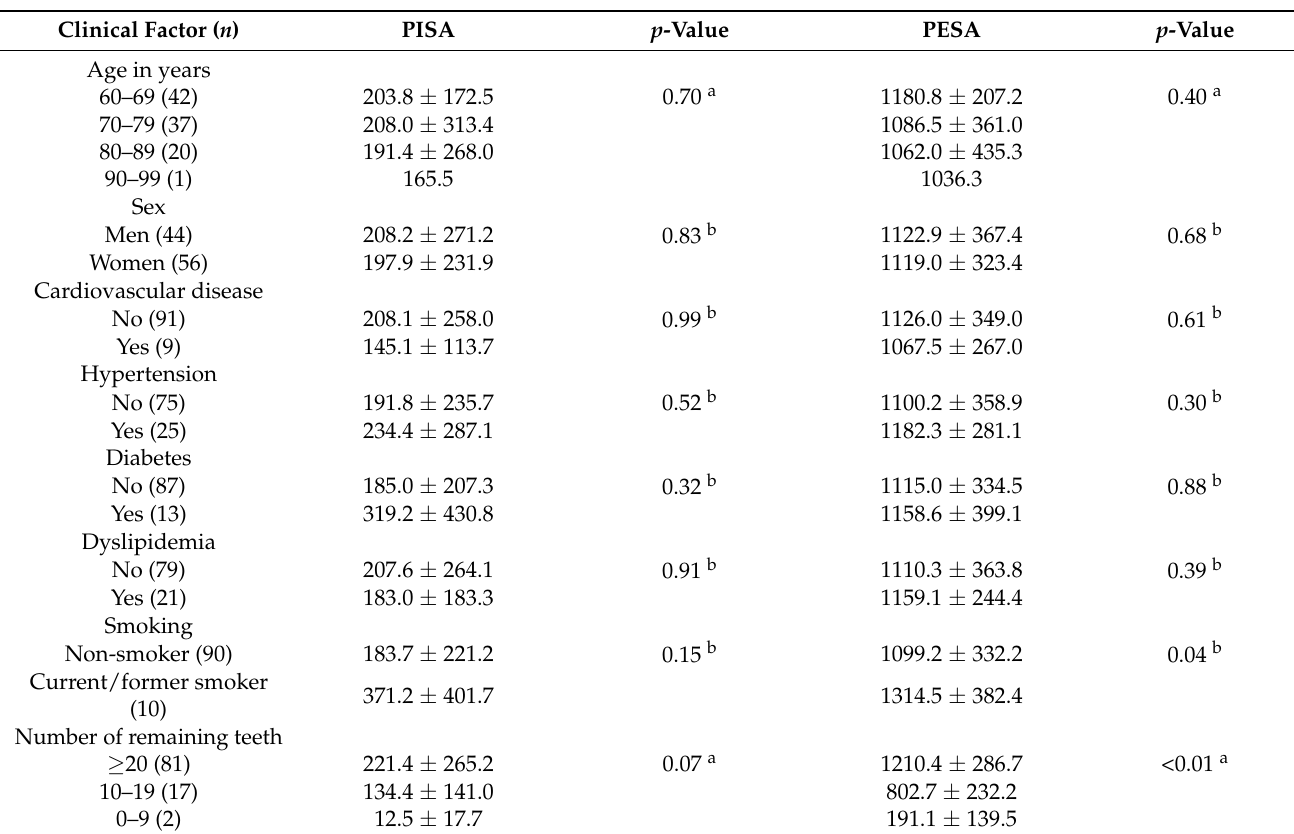
Table 2. Associations of clinical parameters with periodontal inflamed surface area (PISA) and periodontal epithelial surface area